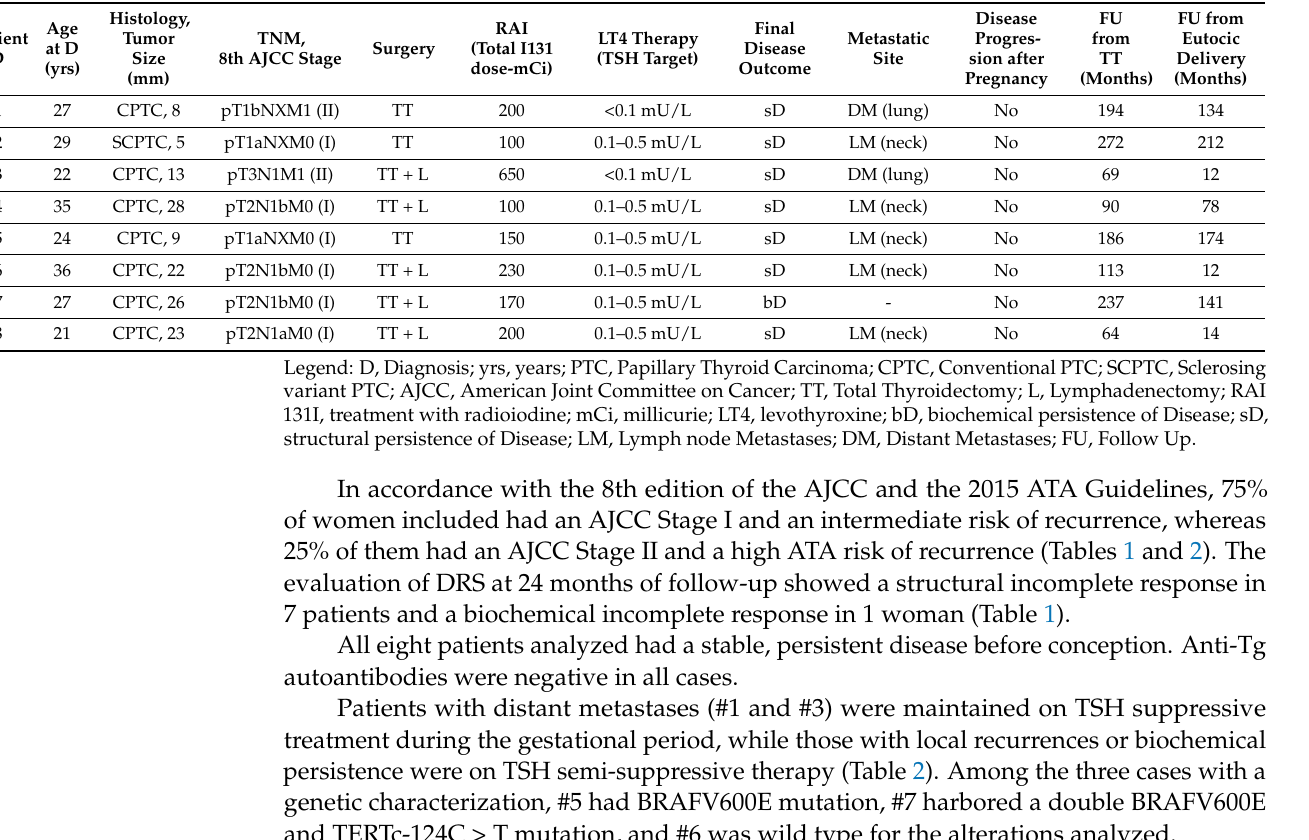
Table 2. Clinicopathological features of 8 PTC patients with Structural or Biochemical Disease Persistence before